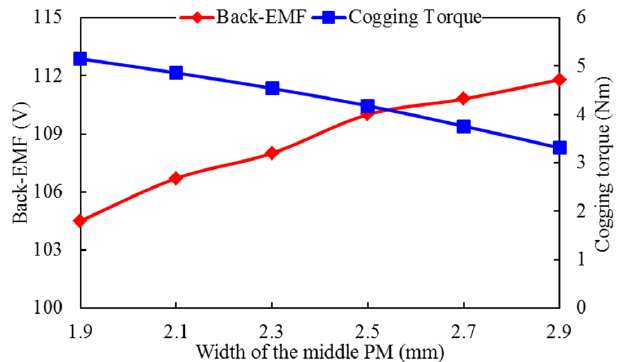
Figure 10. Variations of back-EMF and cogging torque with the width of the middle PM optimization.